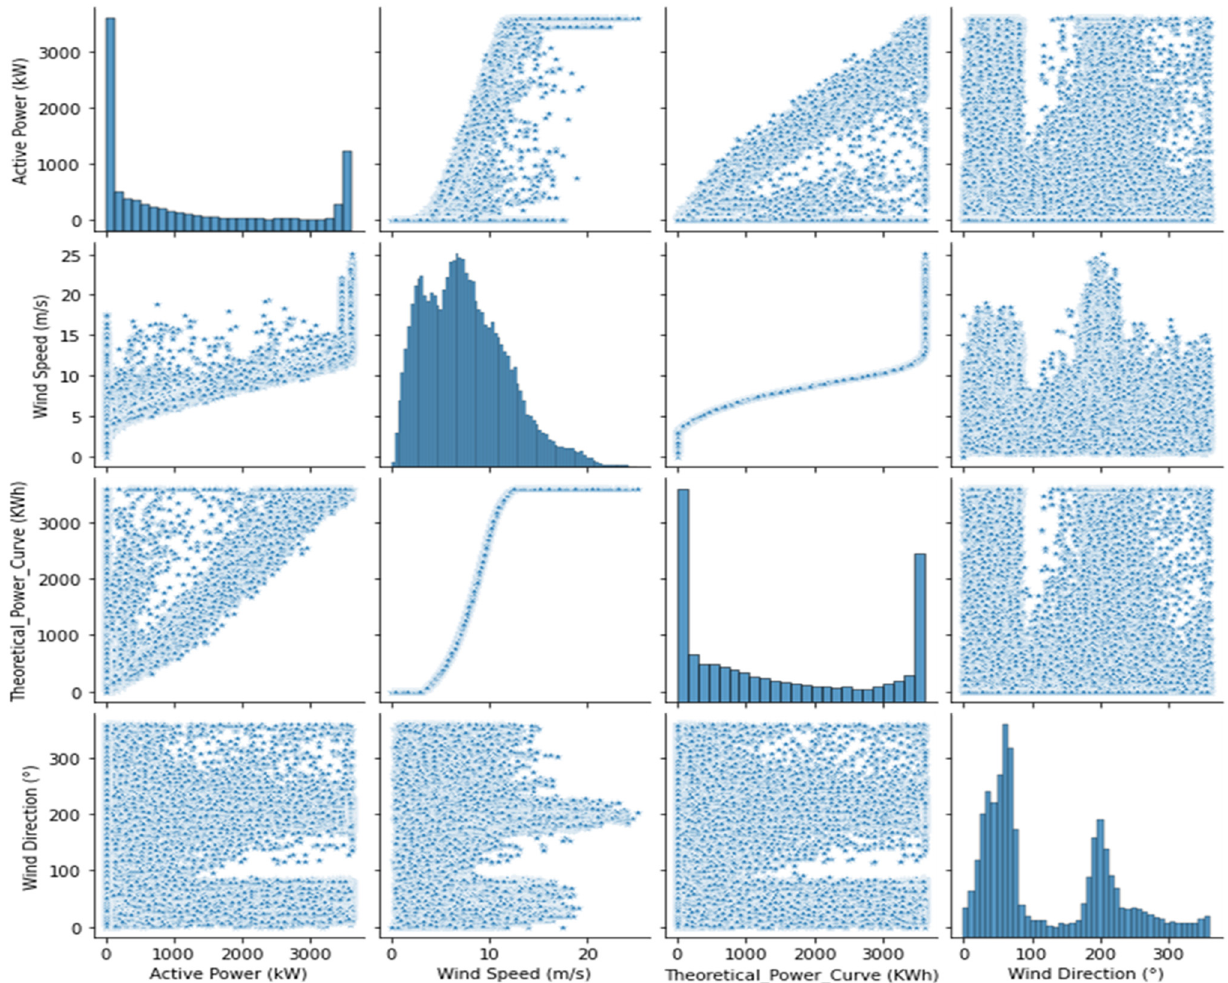
Figure 6. Scatter plots demonstrating the relationships between the input and output parameters.